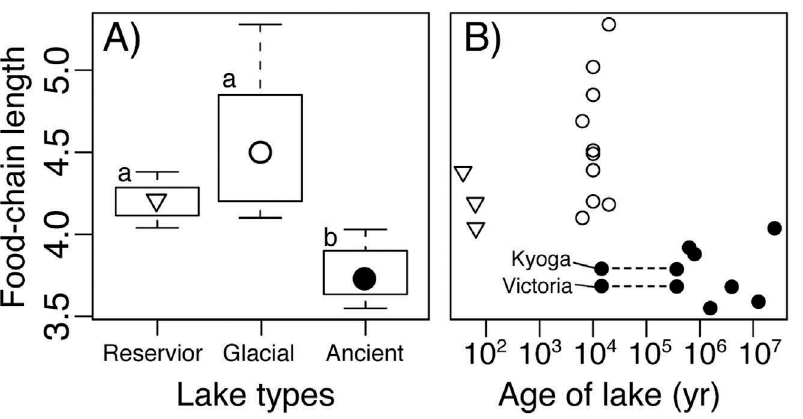
Figure 1. Food-chain length in lakes of different origins and age. A) Boxplot for food-chain length in lakes of different origins. Symbols represent the median FCL, boxes = inter-quartiles, and bars = maximum and minimum values. Different letters indicate significant differences by multiple comparison using ANOVA (p , 0.001). B) Correlation between age of lake and food-chain length. Different symbols are for reservoir, glacial and ancient lakes (see A). Lake Victoria and Lake Kyoga are originally from 400,000 years ago, but are thought to have dried up 14,600 years ago.